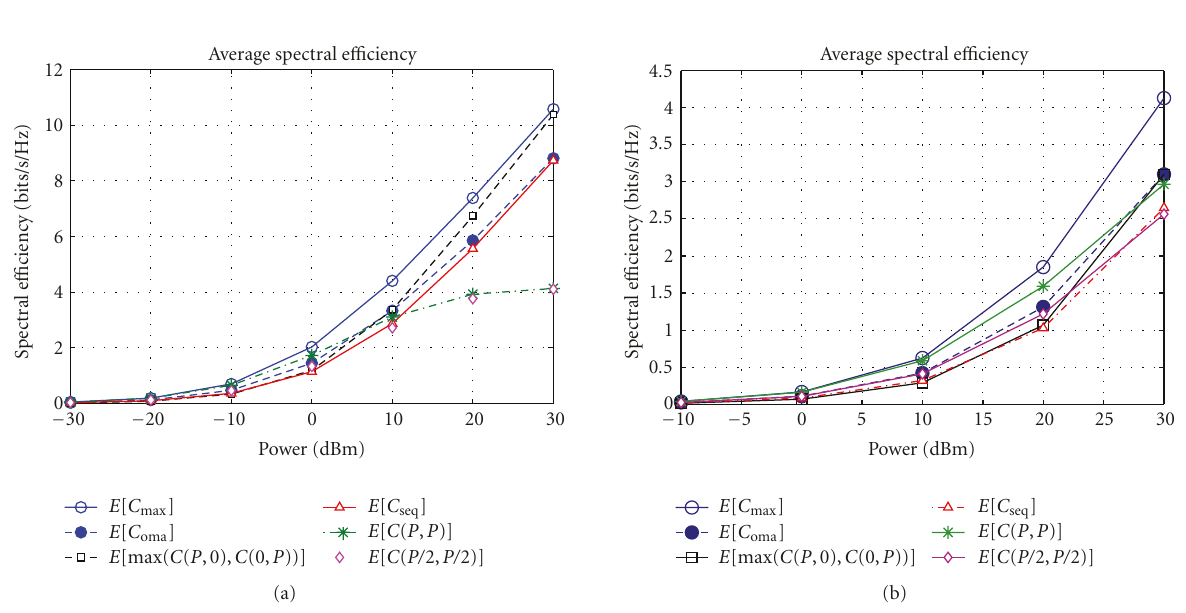
Figure 6: Average system spectral e ffi ciencies for various transmission schemes. Channel realisations are drawn from a uniform distribution of users on a disk with radius R . (a) Disk radius R = 100m, (b) Disk radius R = 500 m.